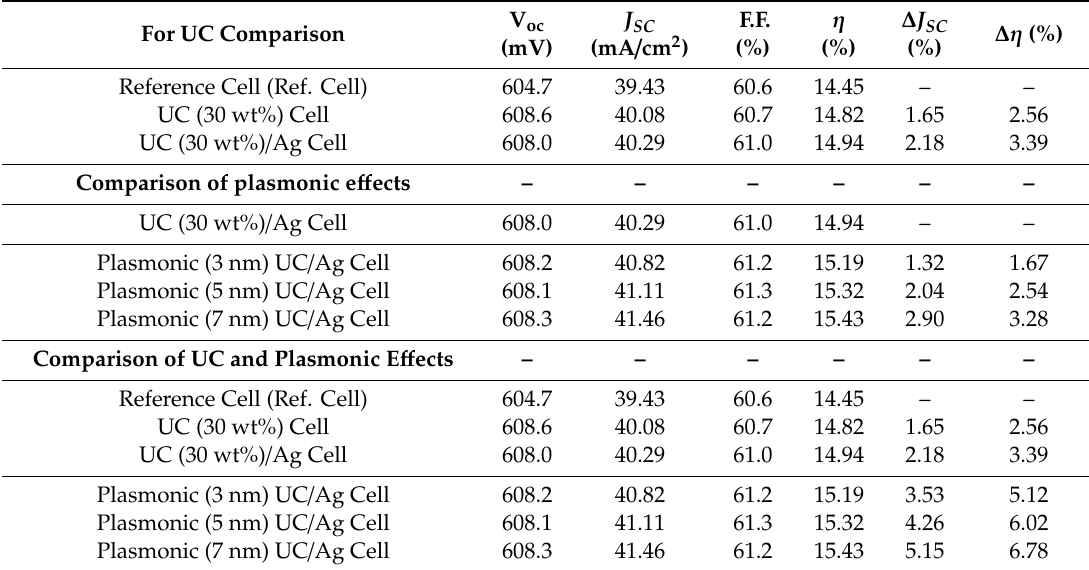
Table 2. Photovoltaic performances of all evaluated solar cells. For UC